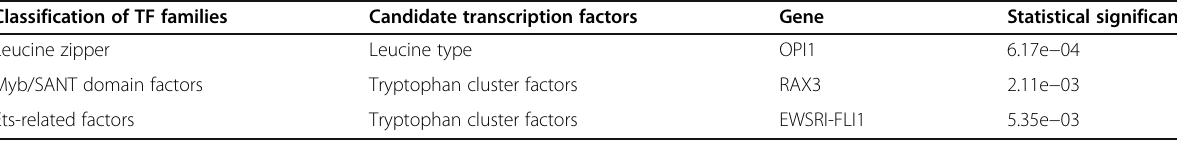
Table 3 Identified transcription factors which could bind to motif